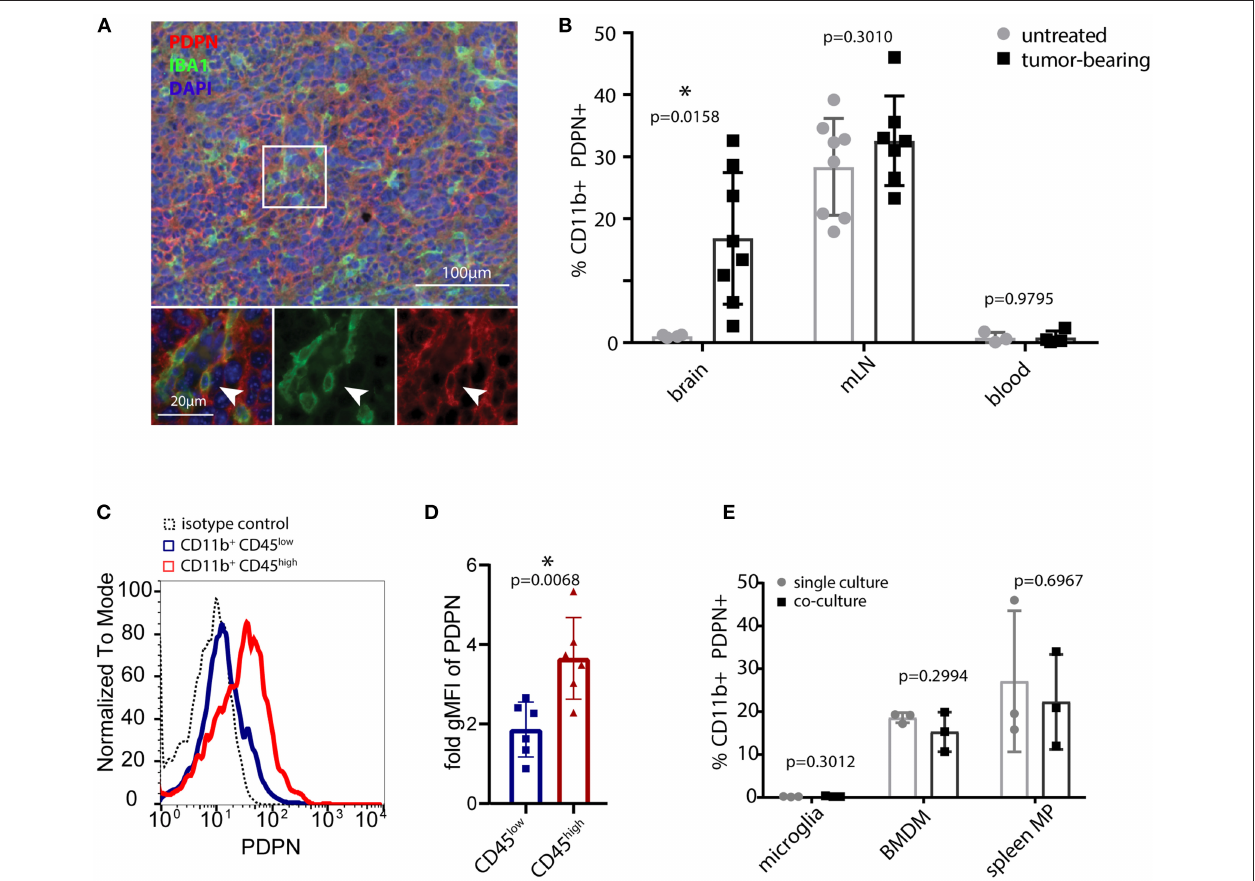
FIGURE 1 | PDPN + myeloid cells are present in lymphoid tissue and glioma tumors. (A) Immunofluorescence staining of high-grade murine glioma for PDPN (red) and IBA1 (green) shows co-expression in a subset of cells. Nuclei were stained with DAPI and pseudocolored in blue. Arrowhead indicates a cell co-expressing PDPN and IBA1. (B) Flow cytometry of brain, mandibular lymph nodes (mLN) and blood of untreated and tumor-bearing mice. Data represent mean and SD. Statistical analysis: Student’s t -test. n = 4 and n = 8 for brain of untreated and tumor-bearing mice respectively. n = 8 and n = 7 mLN of untreated and tumor-bearing mice respectively. n = 3 and n = 4 for blood of untreated and tumor-bearing mice respectively. (C) Flow cytometry of glioma-associated myeloid cells shows PDPN is predominantly expressed by CD11b + CD45 high cells. (D) Quantification of geometric mean fluorescence intensity representative for PDPN levels on CD11b + CD45 low and CD11b + CD45 high cells, normalized to isotype control staining. Statistical analysis (Student’s t -test of logarithmized values) revealed significantly higher expression of PDPN in CD11b + CD45 high cells, p = 0.007; n = 6. (E) Flow cytometry of PDPN expression of microglia, bone marrow-derived macrophages (BMDM) and spleen macrophages in single- or co-culture with glioma cell line LN308. Bar graphs indicate percentage of PDPN + cells of all CD11b + cells, data represent mean and SD. Statistical analysis: Student’s t -test. n = 3 for all samples. * p < 0.05, ** p <